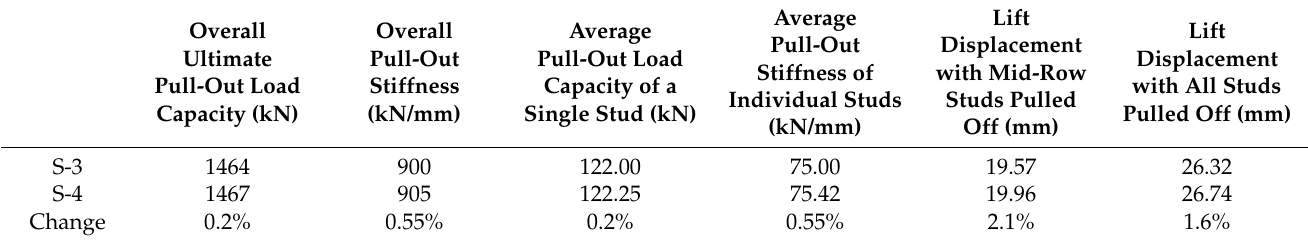
Table 4. Result comparison of the pull-out test specimens.